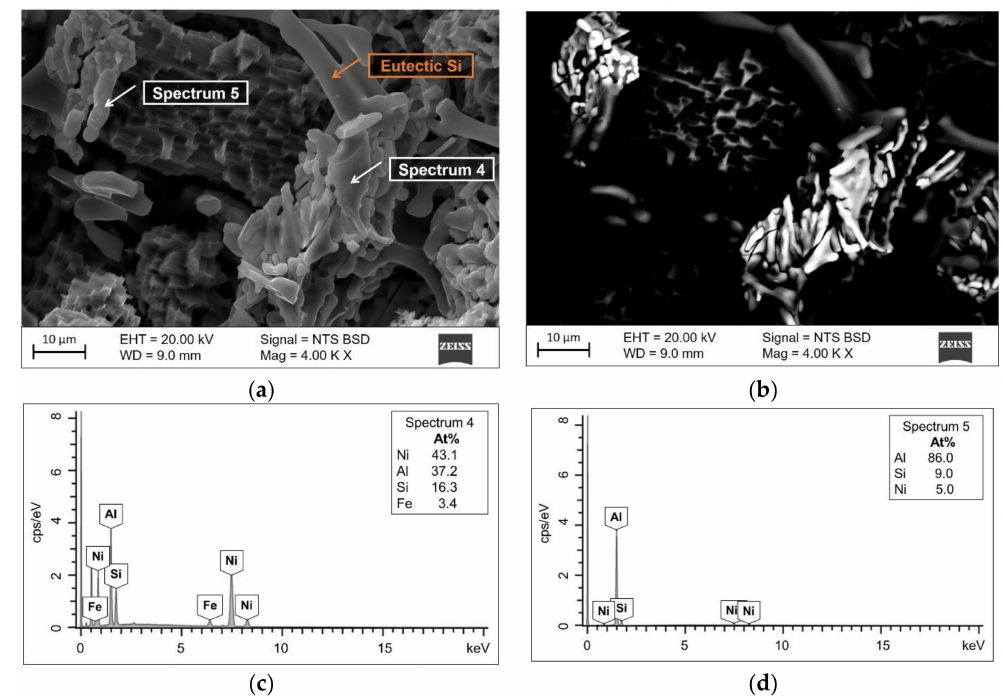
Figure 4. SEM micrographs of Ni-based intermetallic compounds in the as-cast alloy containing 1 wt %